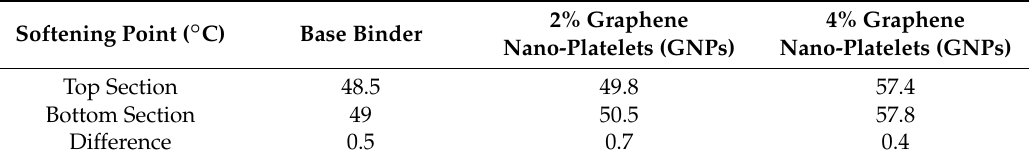
Table 4. The softening point test results for storage